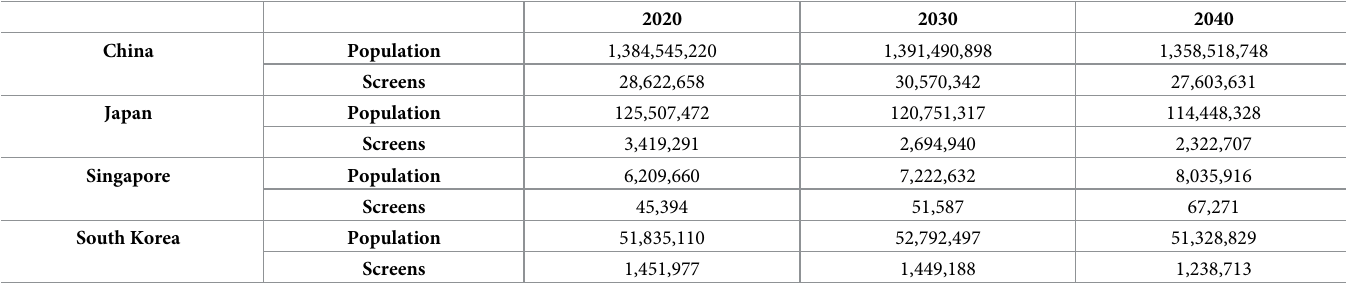
Table 2. Projected population and number of screening-eligible individuals,